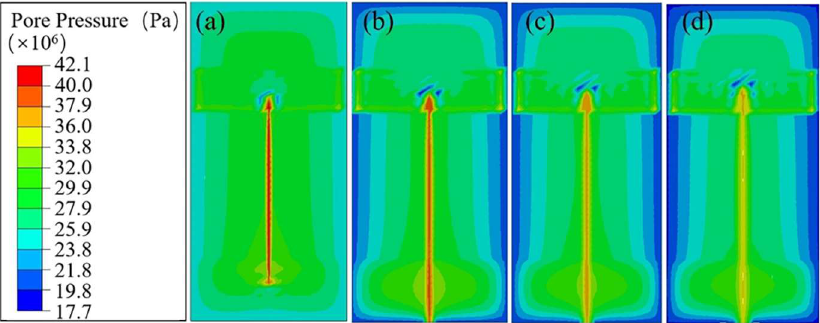
Figure 15. Pore pressure distribution cloud after fracturing under different pumping rate: ( a ) 0.04 m 3 /s, ( b ) 0.08 m 3 /s, ( c ) 0.1 m 3 /s, ( d ) 0.12 m 3 /s.